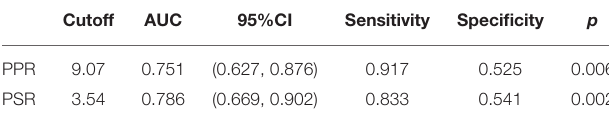
TABLE 5 | Efficacy of the PPR and PSR for evaluating hepatic-fibrosis progression among HBV-infected patients with HBeAg-negativity and a normal ALT level. Cutoff AUC 95%CI Sensitivity Specificity p PPR 9.07 0.751 (0.627, 0.876) 0.917 0.525 0.006 PSR 3.54 0.786 (0.669, 0.902) 0.833 0.541